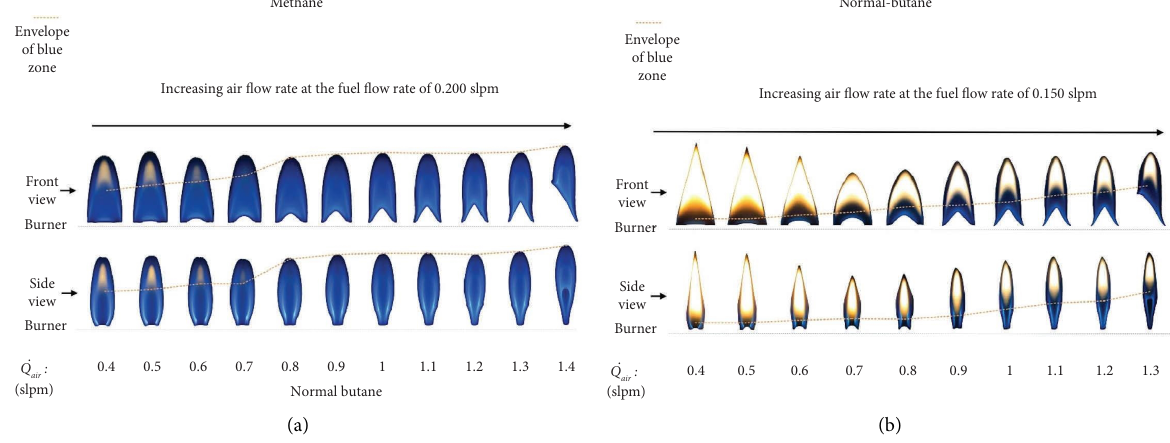
Figure 8: Te efects of the airfow rate increase on the fame appearance and structure for (a) methane and (b)